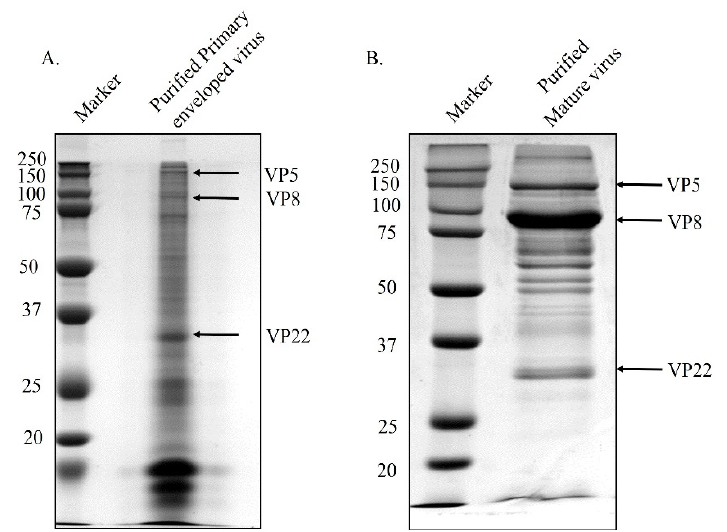
Figure 2. Purified primary enveloped virus ( A ) and mature virus ( B ). MDBK cells were infected with BoHV-1, and virus was purified from the perinuclear membrane at 8 h post-infection, and from the culture medium at 18 h post-infection. The proteins were separated by SDS-PAGE on 8% reducing gels and stained with ProtoBlue Safe. The positions of the capsid protein VP5 and tegument proteins VP8 and VP22 are indicated with arrows. Molecular weight markers (MWs) ×10 − 3 are shown in the left margin.